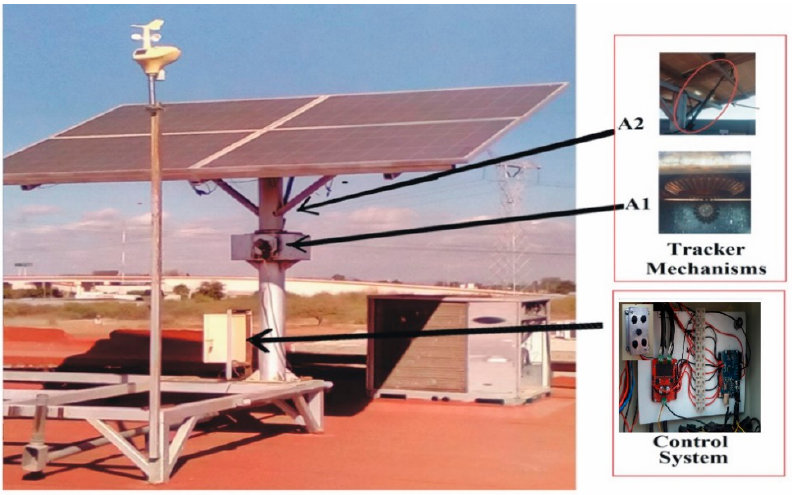
Figure 11. Solar tracker prototype and components.